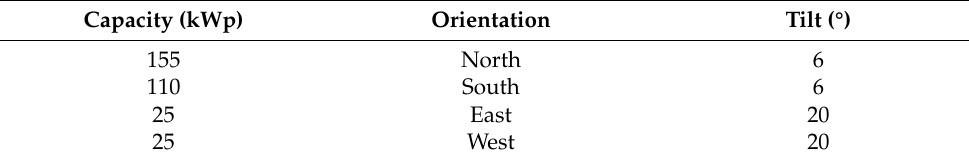
Table 3. Characteristics of solar PV of community installations.